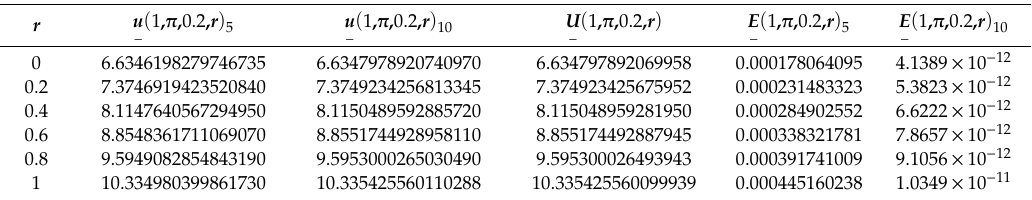
Table 8. Solution and accuracy of fifth and tenth order double parametric fuzzy HPM solutions for Equation (32) at t = π , x = 1 and b = 0.2 for all r ∈ [ 0,1 ] .